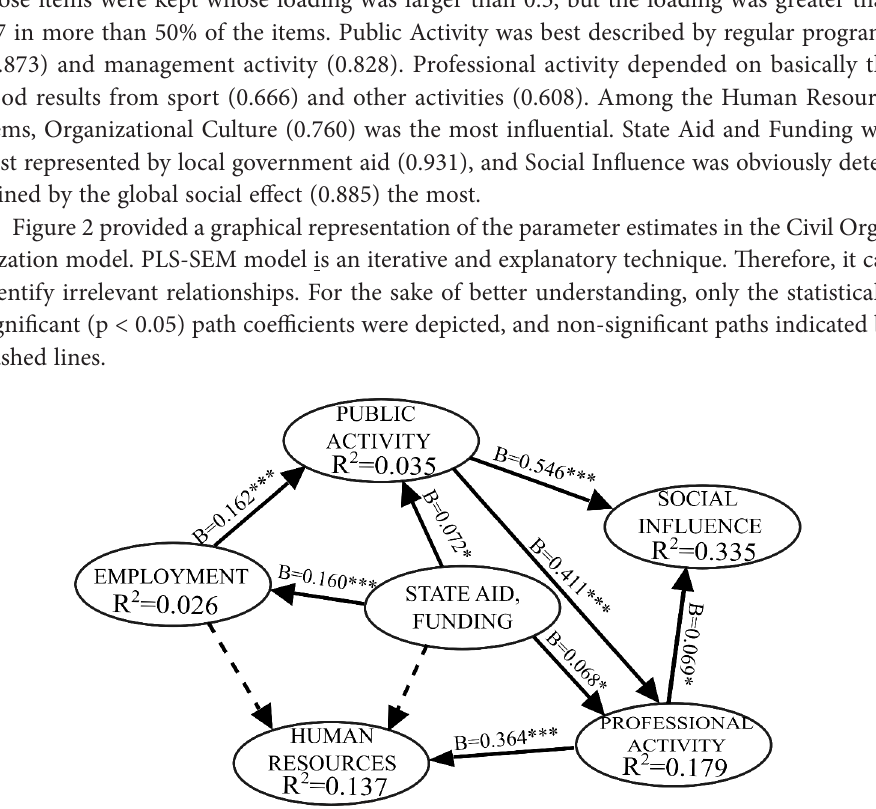
Figure 2. Final Path model and path coefficient